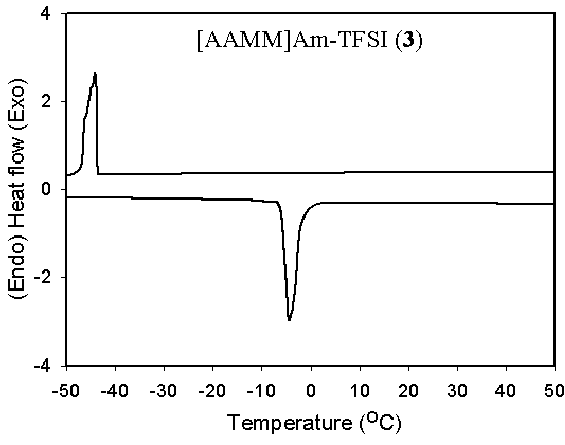
Figure 1. The DSC chart of [AAMM]Am-TFSI ( 3